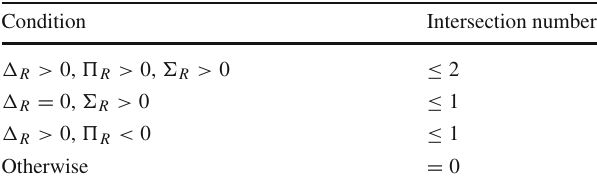
for critical points φ 0 and i